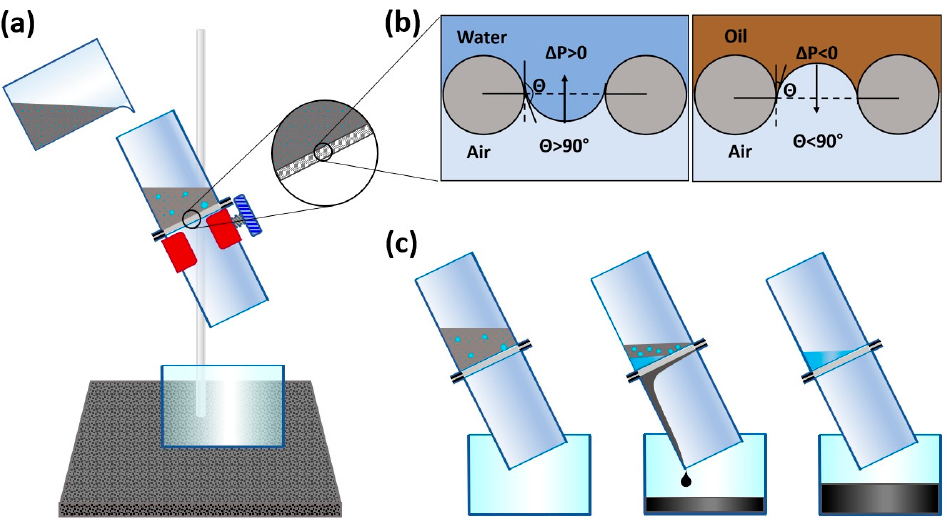
Figure 2. ( a ) Experimental stand for separation. ( b ) Schematic showing the oil – water separation mechanism on the superhydrophobic mesh. ( c ) Schematic of the separation process. mechanism on the superhydrophobic mesh. ( c ) Schematic of the separation